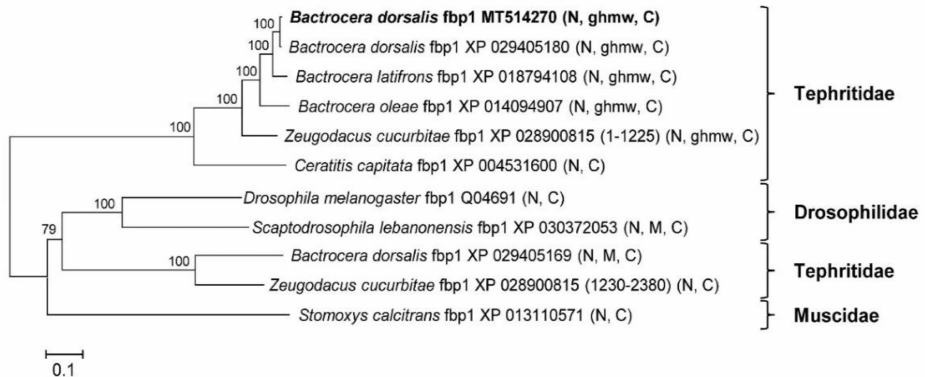
Figure 4. The phylogenetic tree of 11 versions of insect fat body protein 1 ( fbp1 ) was constructed by neighbor joining. Numbers at nodes are based on bootstrapping statistical support. Scale bar = 0.1 substitution/site. Conserved domains in parentheses are preceded by the scientific name, and the accession number. N: hemocyanin N; M: hemocyanin M; C: hemocyanin C; ghmw: high molecular weight glutenin